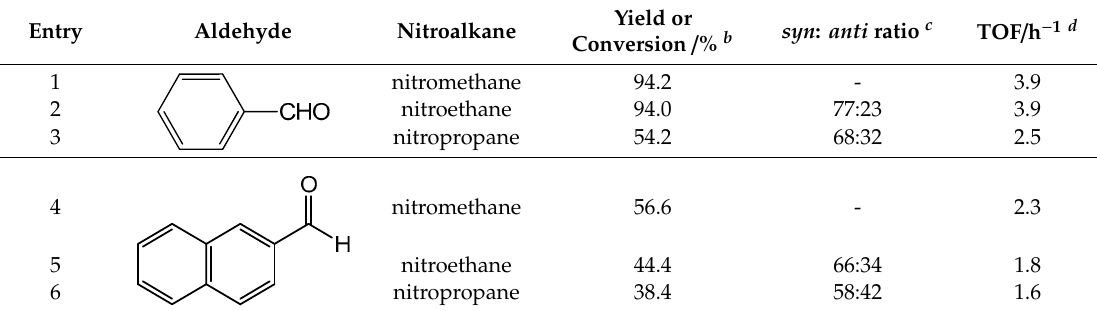
Table 5. Solvent-free nitroaldol condensation of different aldehydes and nitroalkanes catalyzed by 2 a . Entry Aldehyde nitromethane 94.2 3.9